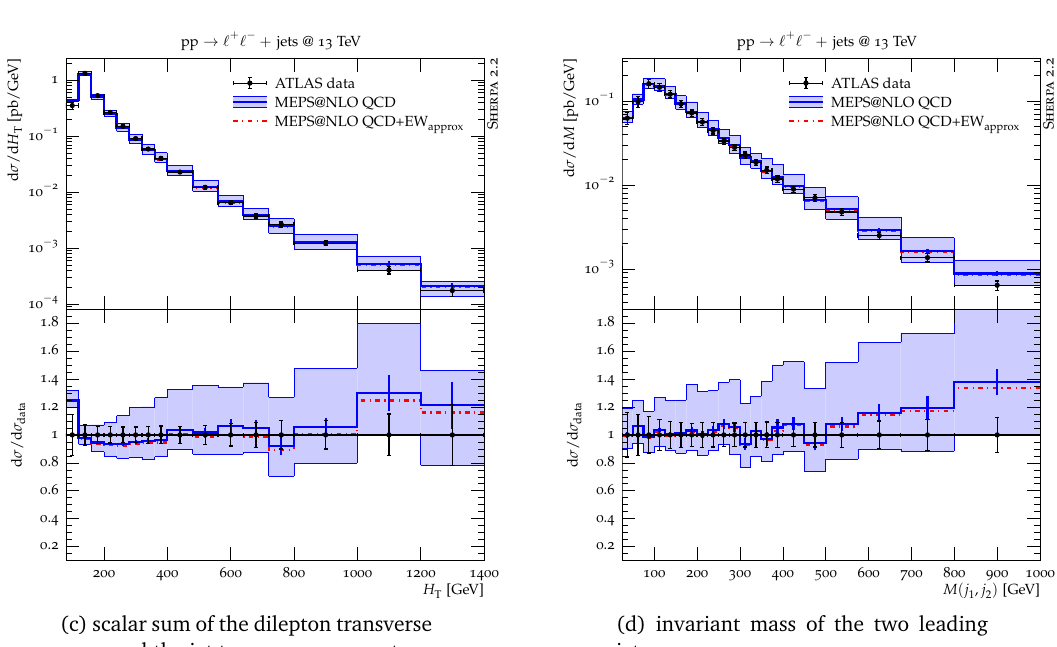
(d) invariant mass of the two leading jets Figure 2: Results for various observables in Z + jets production at the L HC . The un- certainty bands for the S HERPA predictions correspond to the envelope over a 7-point scale variation, whereas their error bars indicate the Monte-Carlo error. In addition, the effect of adding approximate electro-weak corrections to the nominal predictions is